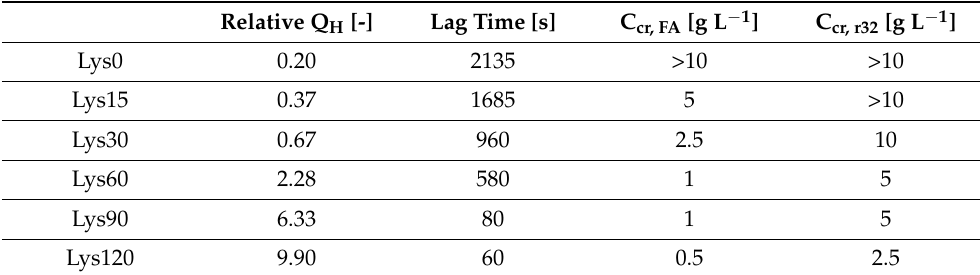
Table 1. Relative exposed hydrophobicity (Q H ), lag time, and critical concentration for foam ability (C cr, FA ) and bubble size (C cr , r32) for (un-)heated